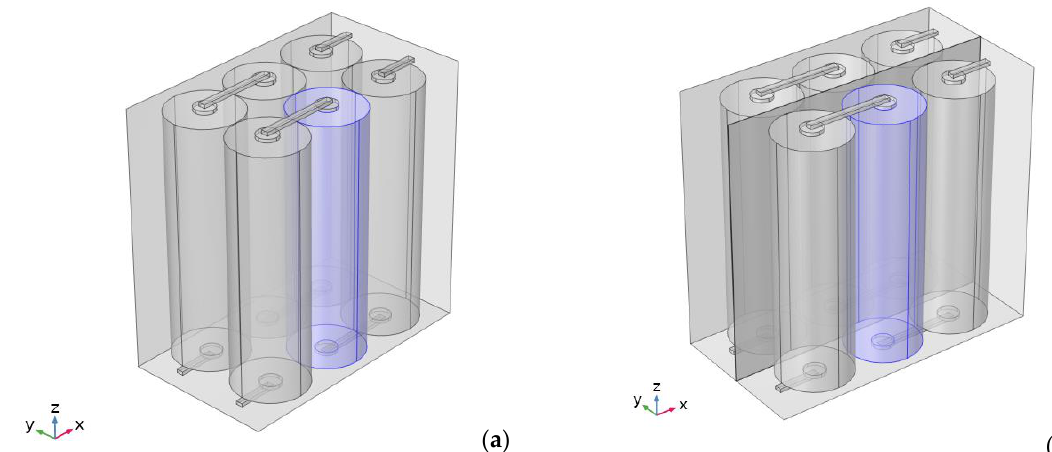
Figure 6. Triggered battery with a T in of 130 ◦ C: ( a ) without GNP layer; ( b ) with GNP layer. Table 3. Thermo-physical parameters of GNP layer used in the simulation.